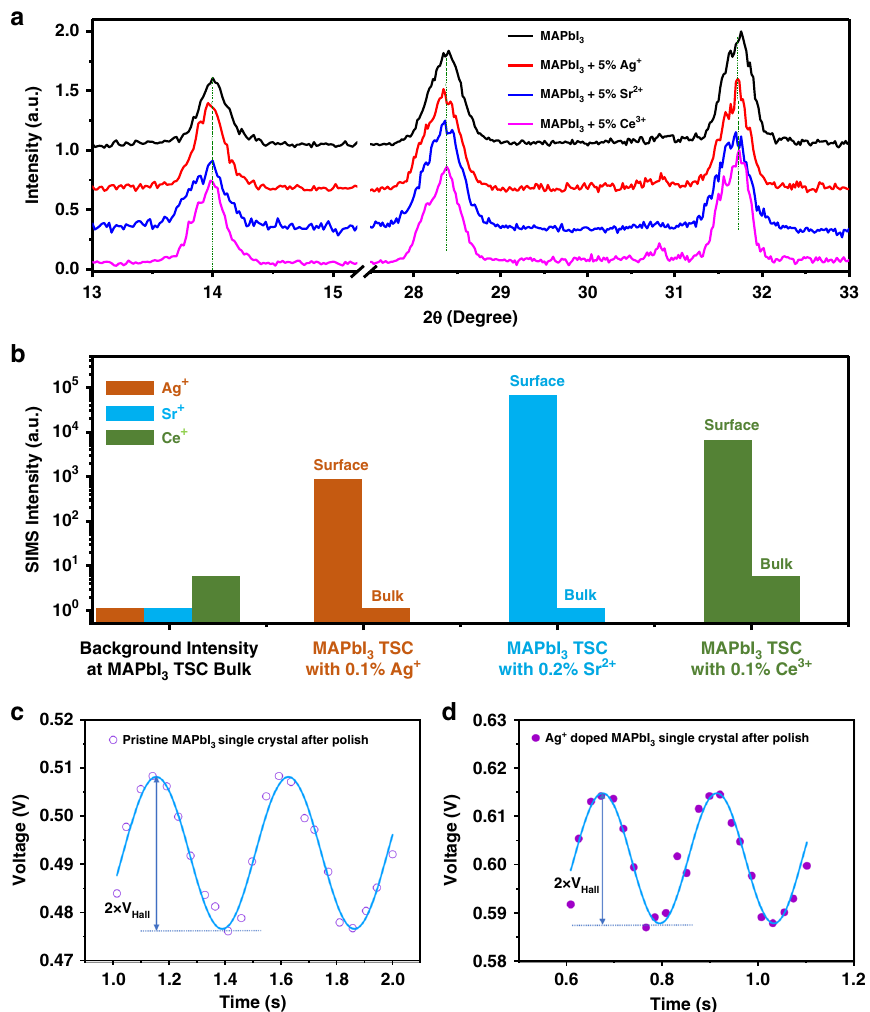
Fig. 3 Distribution of metal ion dopants. a XRD curves of MAPbI 3 powder without and with 5 wt.% Ag + , Sr 2 + or Ce 3 + additives. b TOF-SIMS intensity of Ag + , Sr + , and Ce + on the surface and at the bulk (>800 nm depth) of MAPbI 3 thin single crystals (TSCs) grown from precursor solution with 0.1% Ag + , 0.2% Sr 2 + , and 0.1% Ce 3 + additives. Here the intensities of extrinsic metal ions within crystal bulk are at the level of background signals in MAPbI 3 thin single-crystal grown from precursor solution without additive. c , d Hall effect measurements of MAPbI 3 single crystals grown in precursor solutions c without and d with 0.1% Ag + additives. We polished the surface of MAPbI 3 singles crystals grown from precursor solution without and with metal ion additives, to avoid the impact of surface doping by the metal ions. The results show that the hole concentrations in the MAPbI 3 single crystals grown in precursor solutions with and without Ag + ions are 1.05 × 10 11 cm − 3 and 1.08 × 10 11 cm − 3 , respectively. The almost same hole concentration indicates that the metal ions would not induce bulk